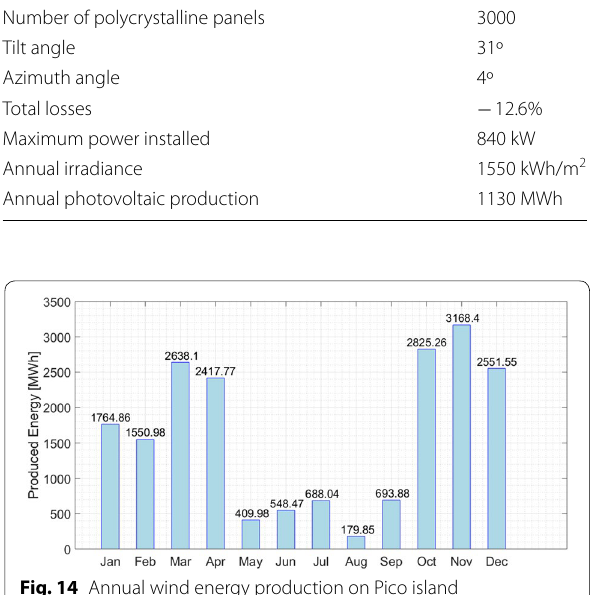
Table 17 Corvo system design data with polycrystalline photovoltaic panels Number of polycrystalline panels